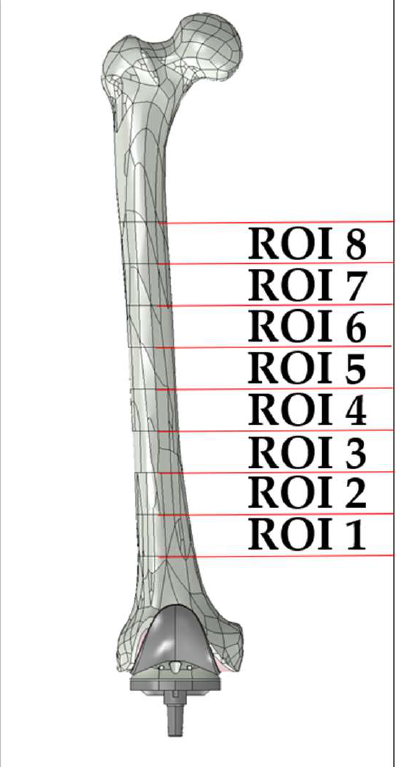
Figure 2. Regions of interest defined for the present study. All of the regions have a height of 30 mm measured along the femoral anatomical axis.